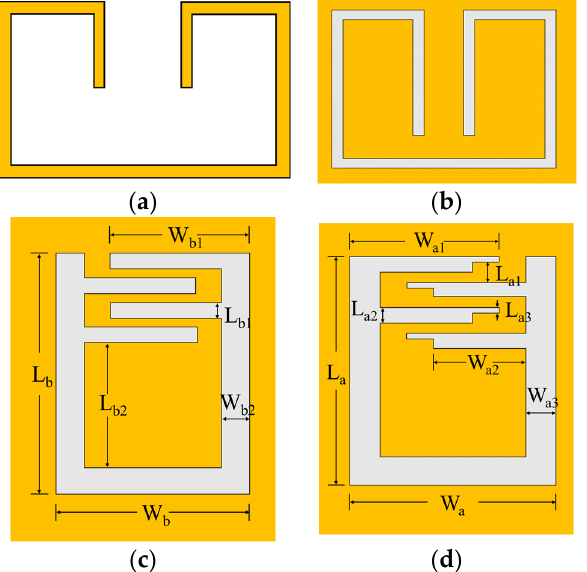
Figure 4. The geometry of band-notched structures: ( a ) curled split-ring resonator, ( b ) curled C- shaped slot, ( c ) interdigital inductance slots 1, and ( d ) interdigital inductance slots 2.